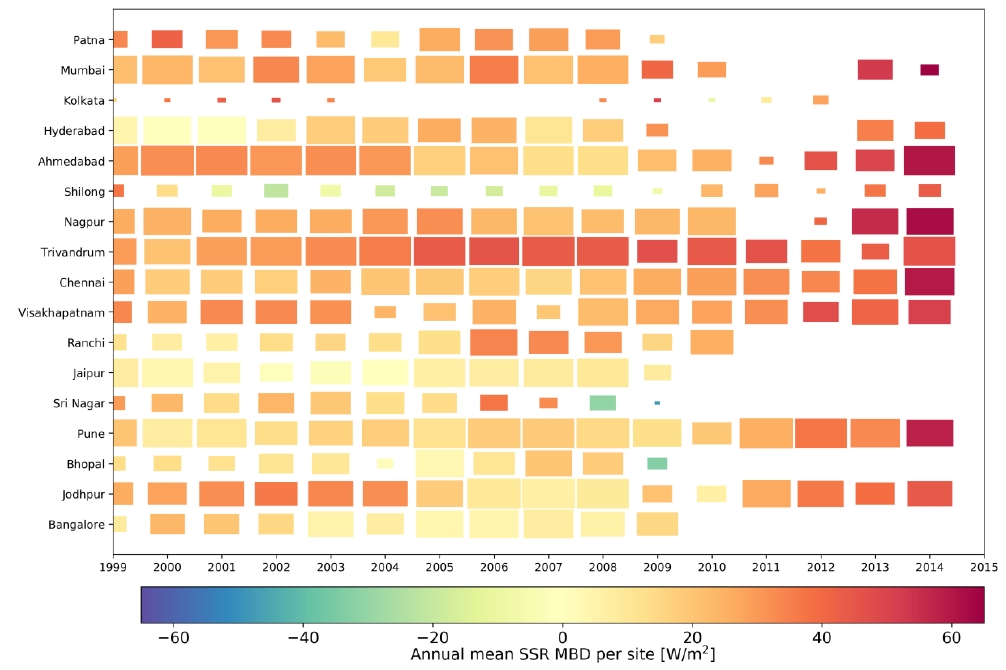
Figure 1. Annual mean SSR estimation bias per site (MBD, satellite minus in situ, W/m 2 ). Rectangle color indicates the magnitude of annual mean SSR bias, size is proportional to the amount of valid in situ measurement days in each year.